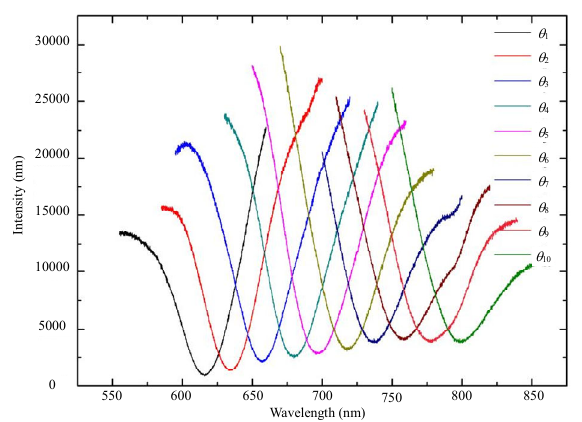
Fig. 12 SPR measurement curves acquired by USB2000 spectrometer (the reflectivity curves from left to right correspond to incident angles θ 1 , θ 2 , θ 3 , θ 4 , θ 5 , θ 6 , θ 7 , θ 8 , θ 9 , and θ 10 ,respectively).